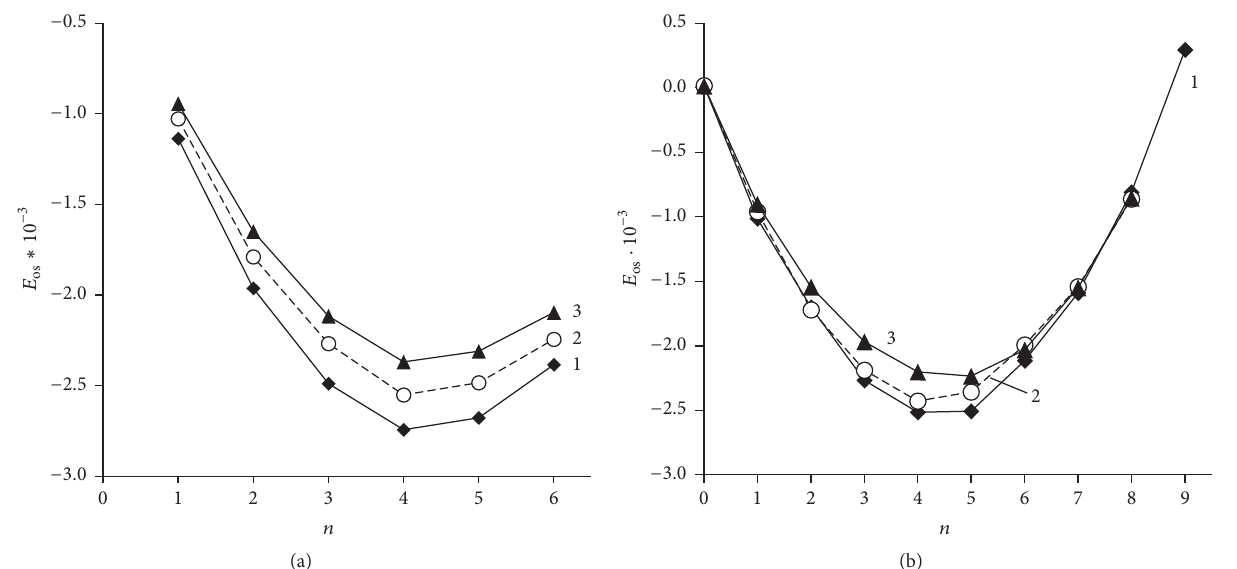
Figure 1: Energy of formation of the complex cationic OS shell 𝐸 os (kJ/mol) versus the number of OS cations ( n ) in systems I (M + ) 𝑛 ⋅ [CrCl 6 ] 3−